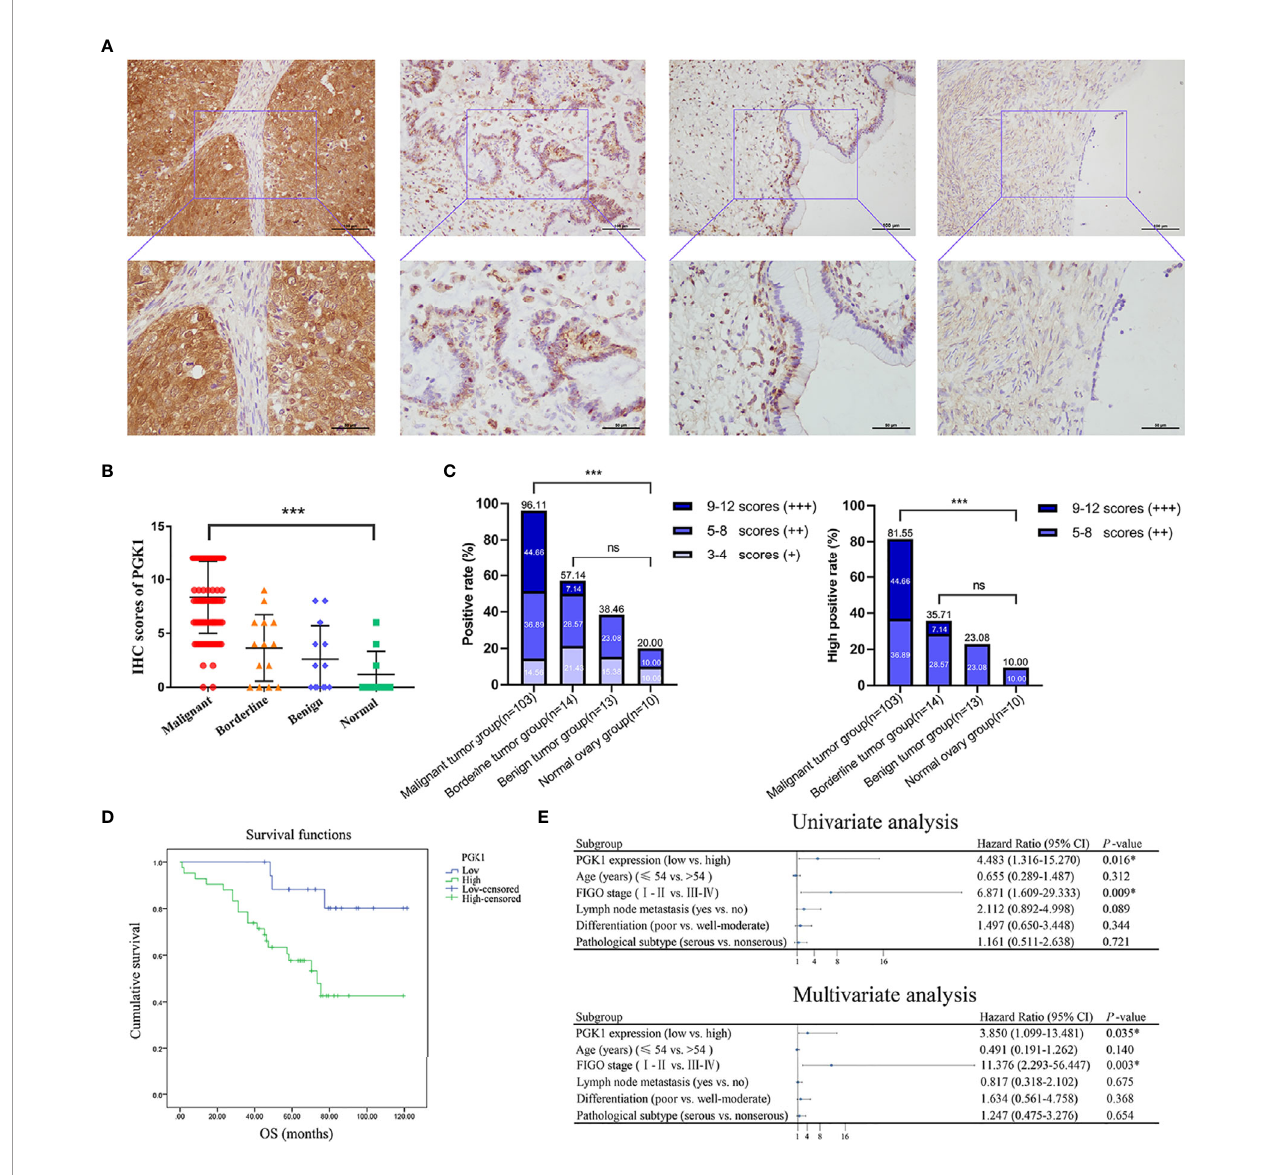
FIGURE 7 | The PGK1 expression level in different groups of ovarian tissue and its prognostic value in epithelial ovarian cancer. (A) Representative immunohistochemical staining images of PGK1 in epithelial ovarian cancer, epithelial ovarian borderline tumor, epithelial ovarian benign tumor, and normal ovarian tissue. (B) PGK1 immunostaining scores in ovarian tissue. (C) Statistical analysis of PGK1 positive rate and high positive rate in different groups. (D) The correlation between PGK1 expression and OS in patients with epithelial ovarian cancer. (E) Forest plot based on univariate and multivariate analyses of patients with epithelial ovarian cancer. *** P < 0.001; ns, non-signi fi